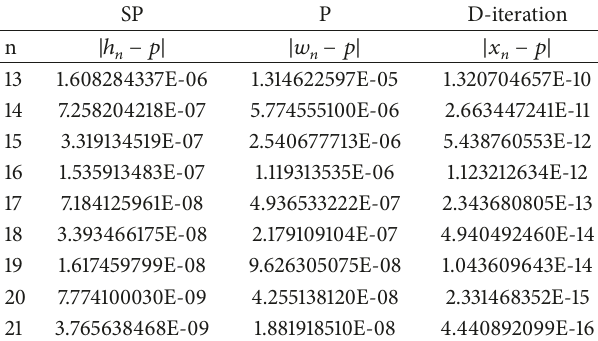
Table 4: The rate of convergence of SP-, P-, and D-iterations for 𝑓(𝑥) = cos (0.2𝑥 + 3) + 𝑥 . SP P D-iteration